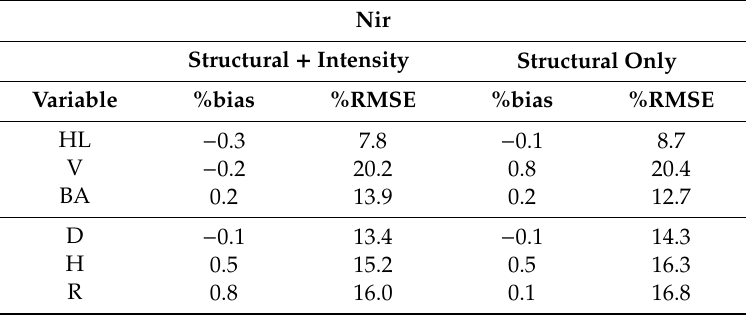
Table 7. %RMSE and %bias results for structural only and combination of structure and intensity models derived from the near-infrared (1064 nm) M-ALS